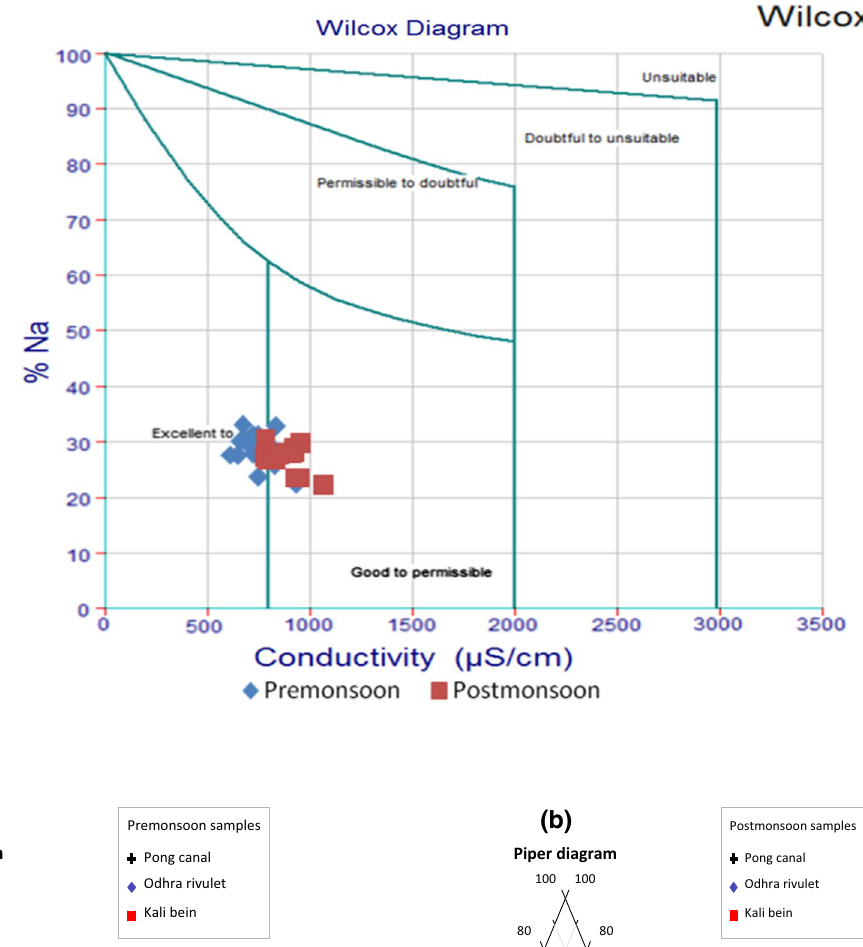
Fig. 3 Wilcox diagram for classification of groundwater samples collected from the proximity of tributaries of Beas River, India on the basis of Na% and EC